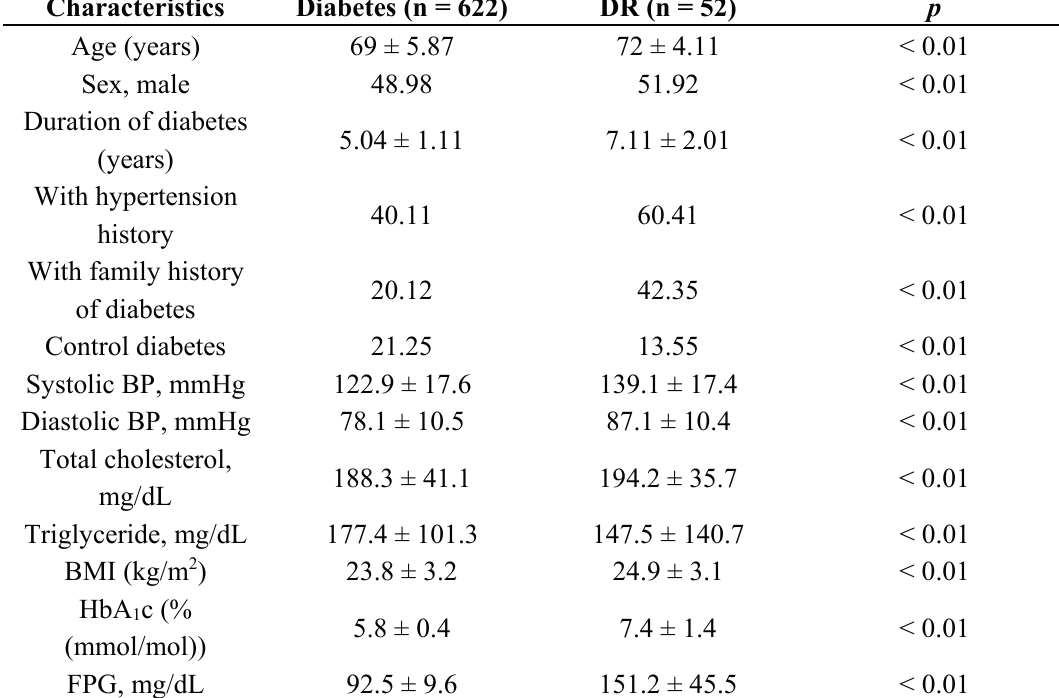
Abbreviation: DR, diabetic